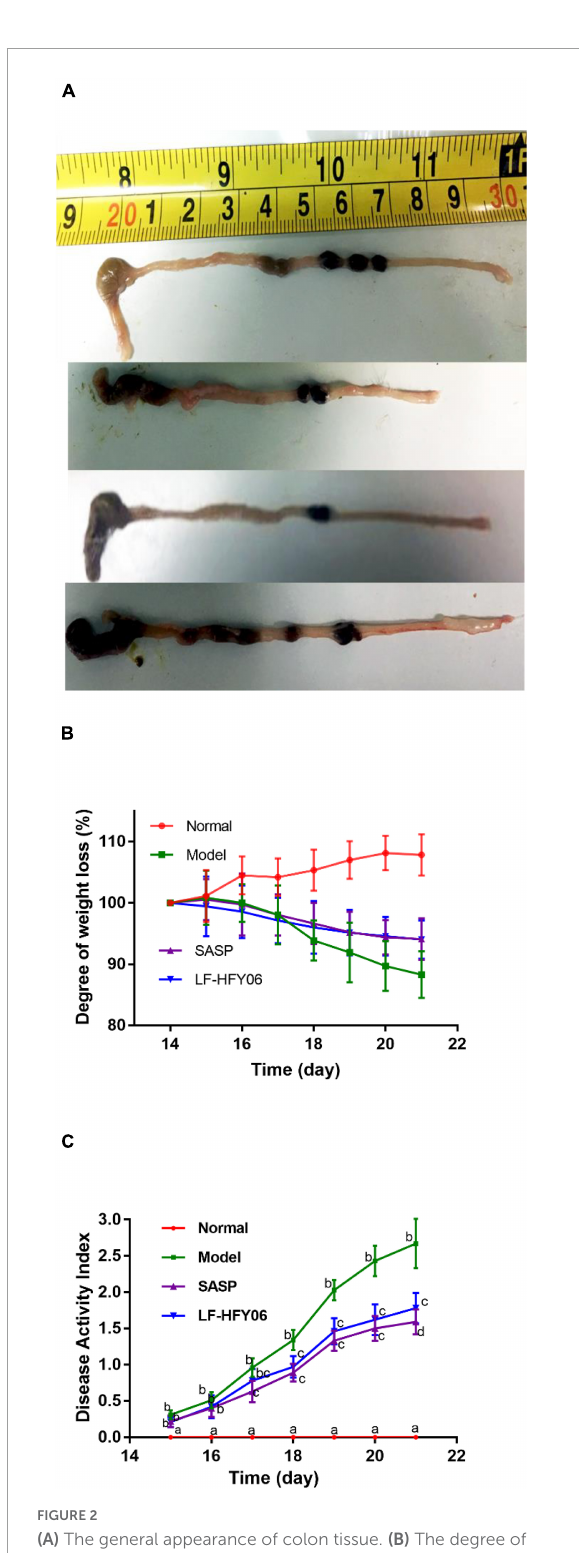
FIGURE2 (A) The general appearance of colon tissue. (B) The degree of weight loss, a - c Mean values with different letters on the same day indicate a significant difference after Tukey’s test ( P < 0.05). (C) Disease activity index of mice in different groups. a - d Mean values with different letters on the same day indicate a significant difference ( P < 0.05) after two-way